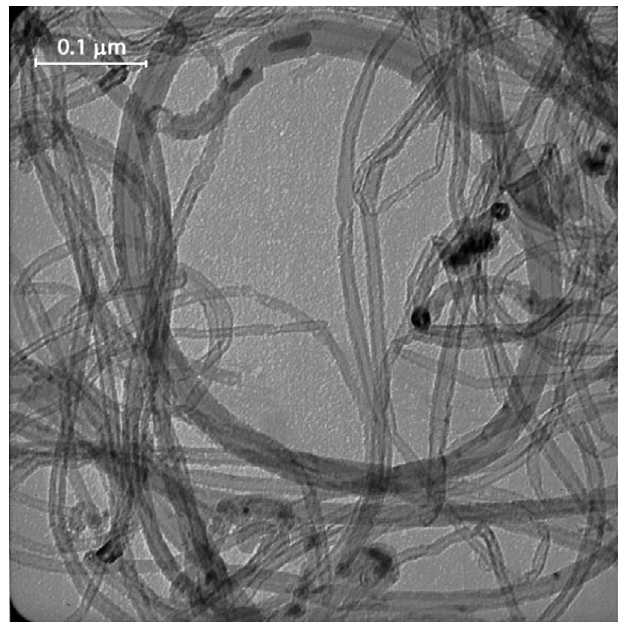
FIG. 1. Transmission electron micrograph of multiwalled car- bon nanotube sample used in this